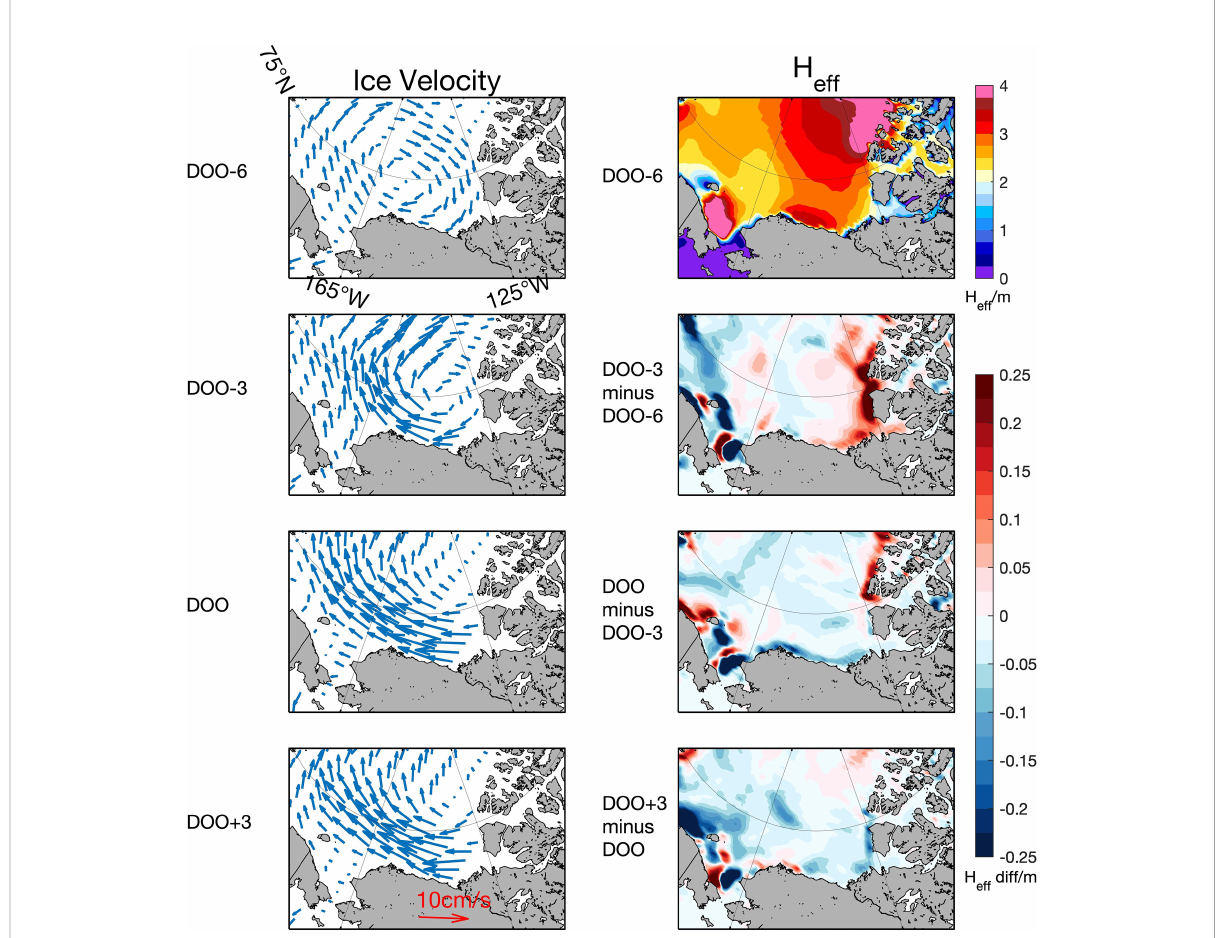
FIGURE 5 Composite ice velocity on DOO-6, DOO-3, DOO, and DOO+3 for the 2000 – 2019 period (left column). Composite effective sea ice thickness ( H eff ) on DOO-6 and changes in H eff thereafter (right